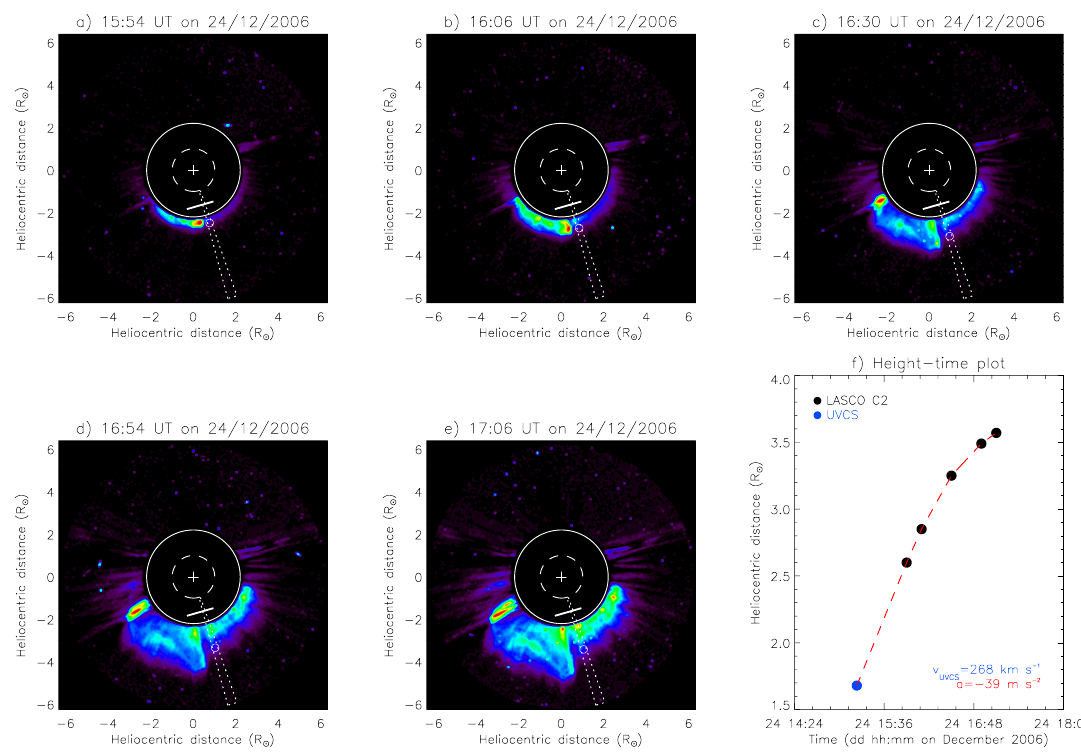
Figure 1. ( a – e ) LASCO C2 base difference images showing the white light corona as observed during the transit of the CME front through the UVCS slit (shown as a white thick line) at 15:54, 16:06, 16:30, 16:54 and 17:06 UT on 24 December 2006; the dashed white line indicates the solar limb, whilst the continuous one shows the LASCO C2 occulter; the dotted area marks the coronal region where the CME front is identified (open circle). ( f ) Height-time plot of the CME front: black and blue dots correspond to the LASCO C2 and UVCS observations, respectively; the parabolic fit (red curve) indicates a deceleration of the CME of ∼− 39 m s − 2 after 15:14 UT and an expansion speed of ∼ 268 km s − 1 at the UVCS position. After 15:14 UT the CME is slowing down with a constant deceleration of about − 39 m s − 2 , as inferred by means of a parabolic fit of the height-time plot of Figure 1f, from an initial expansion speed of ∼ 268 km s − 1 measured at the UVCS slit position. The propagation direction of the region of the CME observed with UVCS is inferred to be primarily in the plane of the sky, since no significant Doppler shift of the emission of the H I Ly α 1216 Å line was detected. This implies that the values of ∼ 268 km s − 1 and − 39 m s − 2 correspond to the expansion speed and deceleration of the coronal plasma observed with UVCS along its direction of